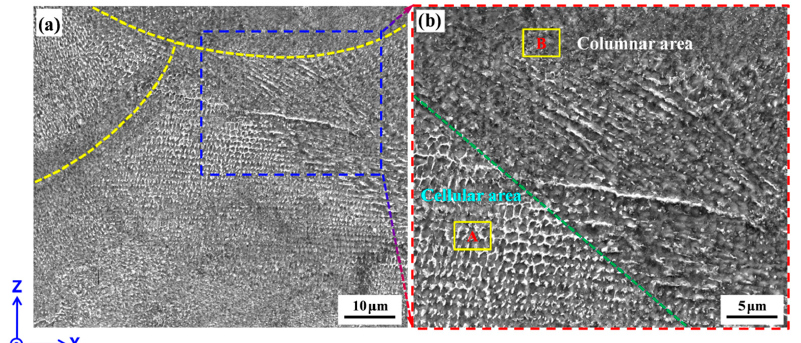
Figure 6. SEM micrographs of the as-built sample in the X–Z plane; ( a ) track–track structures consisting of overlapping area and central fusion area, and ( b ) dendrites and cellular sub-structures contained in the overlapping region.